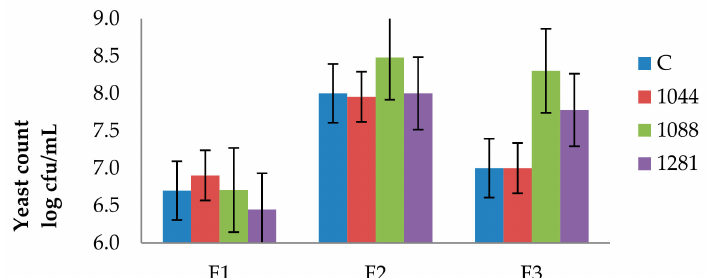
Figure 1. The growth of yeasts during fermentation. F1 is the beginning of fermentation, F2 is middle of fermentation, and F3 is end of fermentation. C represents wine inoculated with control strain, 1044 represents wine inoculated with 1044, 1088 is wine inoculated with 1088, and 1281 is wine inoculated with 1281.